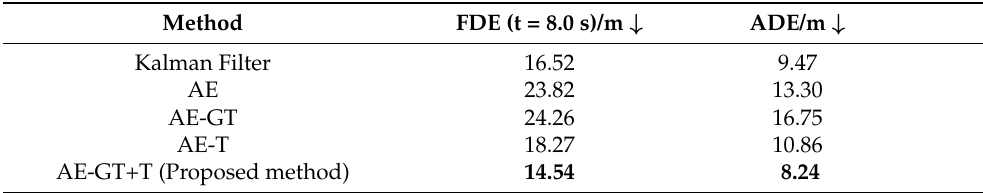
Table 4. Prediction performance for tracker trajectories inputs, where we propose the AE-GT+T method, which outperforms the existing Kalman filter method in both the FDE and ADE